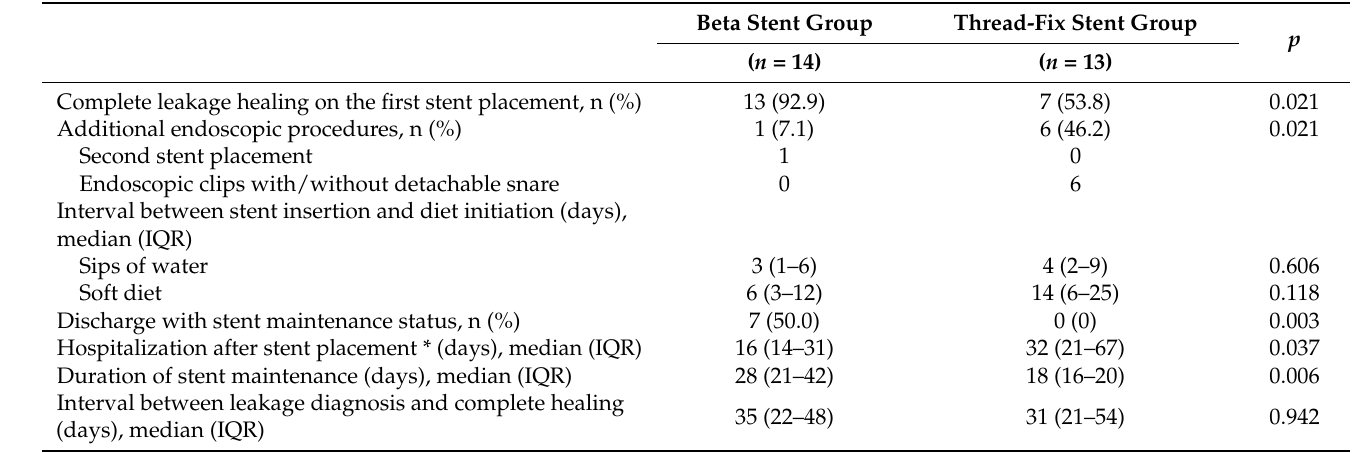
Table 3. Therapeutic outcomes and complications by